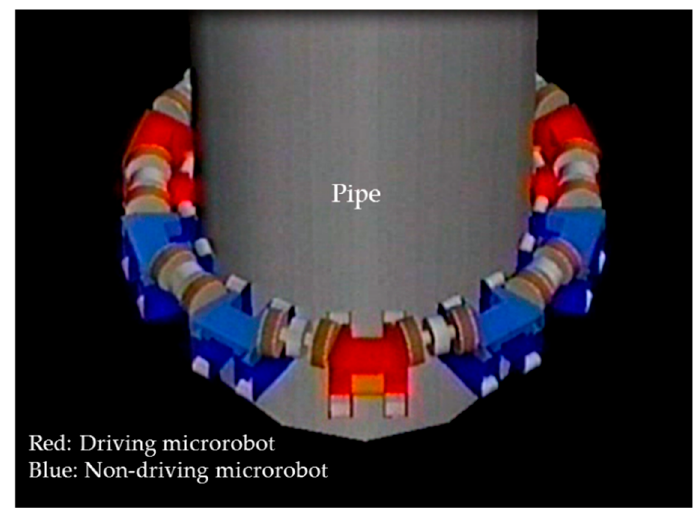
Figure 16. Simulation results (animation display) of 10 connected microrobots. Red microrobots show driving microrobots and blue microrobots show non-driving microrobots. The animation result shows that three driving microrobots can move seven non-driving microrobots.